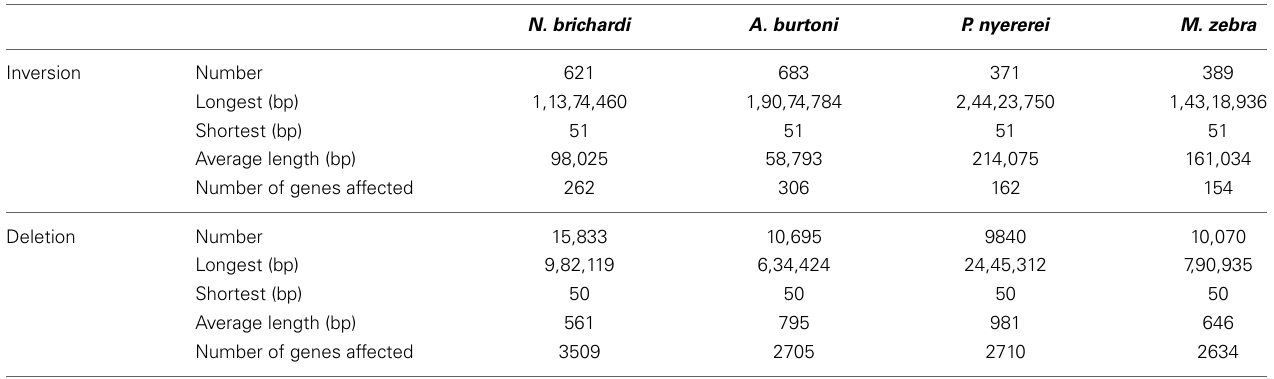
Table 2 | Summary of the inversions and deletions in the African cichlid